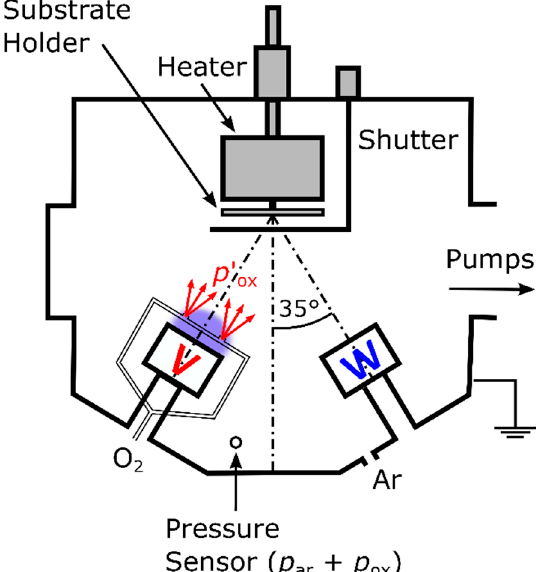
Figure 1. Schematic diagram of the magnetron sputter device showing two magnetrons with V and W targets, located in opposite positions, which were used for the deposition of the active V 0.984 W 0.016 O 2 layers. Two O 2 inlets were placed 20 mm from the V target surface and oriented to the substrate. Positions of the pressure sensor and the Ar inlet in the vacuum chamber wall are also shown. An increased local value of the oxygen partial pressure due to the O 2 injection is denoted as p ’ ox .